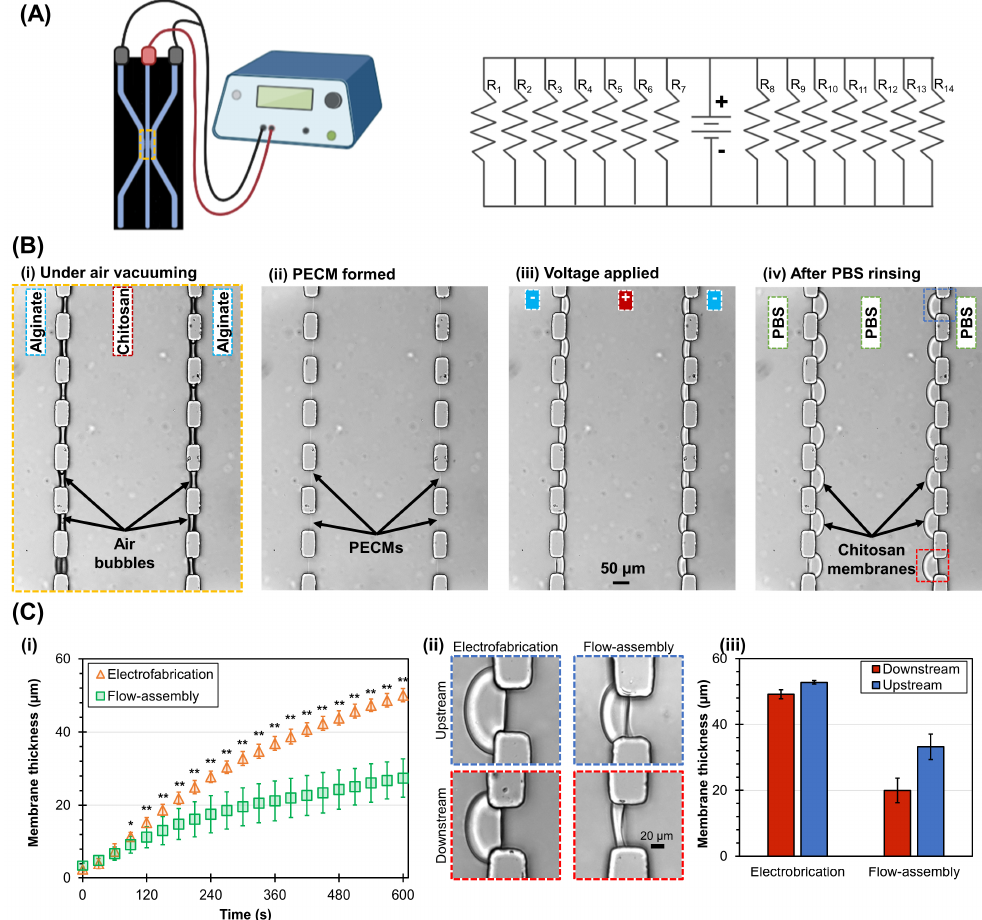
Figure 8. Scaling up the electrofabrication of chitosan membrane arrays in a three-channel PDMS microdevice with distal electrodes. ( A ) Electrical circuit representation of the scaled-up electrofab- rication and experimental setup schematics. ( B ) Electrofabrication of chitosan membrane arrays in a three-channel PDMS device in sequence: ( i ) air bubbles were trapped within the apertures and vacuumed d out with an add-on vacuum chamber; ( ii ) PECMs were formed at the solution interfaces upon the contact of chitosan and alginate solutions; ( iii ) voltage was applied to initiate the formation of chitosan membrane arrays in stop flow condition; ( iv ) final chitosan membrane arrays formed and stored in PBS. ( C ) The growth of electrofabricated and flow-assembled chitosan mem- branes over time: ( i ) typical membrane growth within 10 min; ( ii ) zoomed-in images and ( iii ) mem- brane thickness of upstream and downstream membranes by the two fabrication approaches. Re- sults of pairwise comparisons are indicated by * ( p < 0.01) and ** ( p < 0.001).